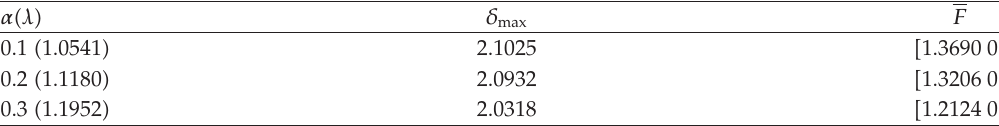
Table 2: δ max and F for di ff erent values of α